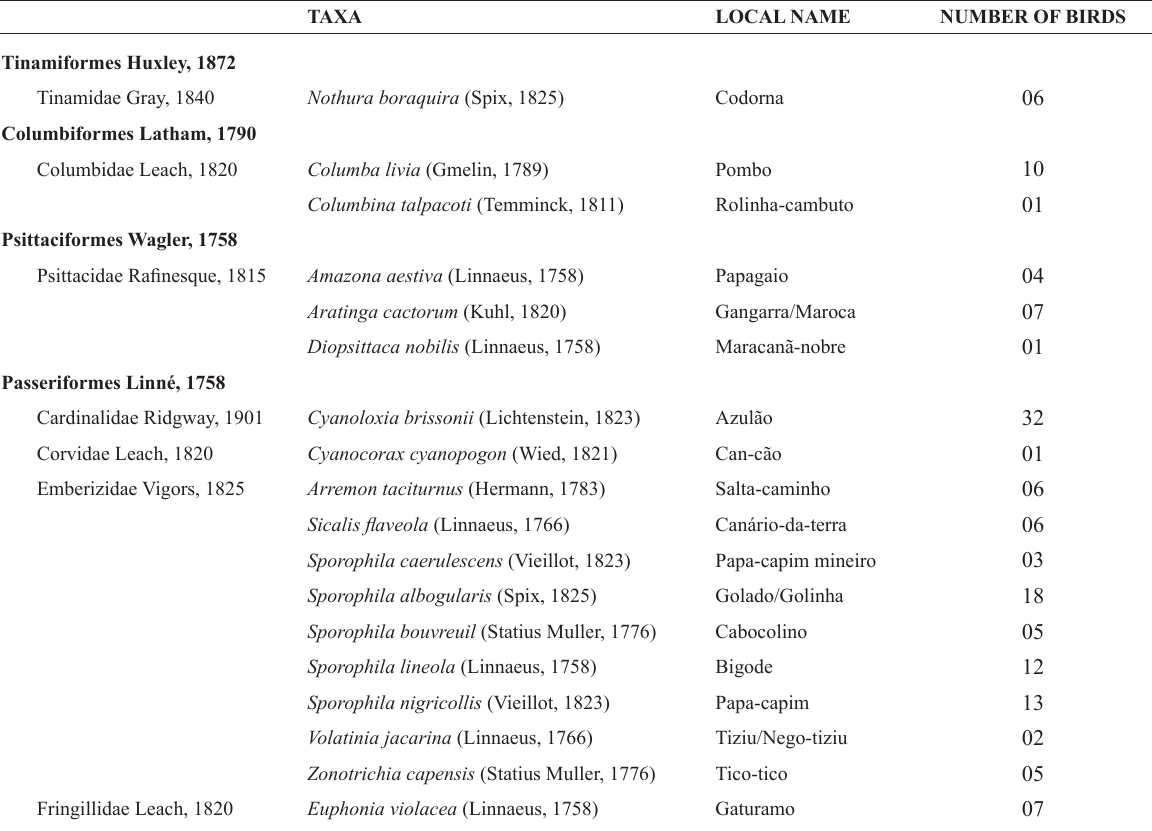
Species of wild birds encountered in the homes of breeders in Campina Grande, Paraíba State,